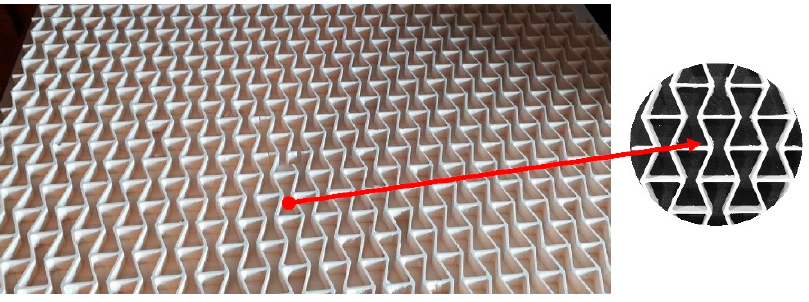
Figure 3. The core with auxetic re-entrant cells.